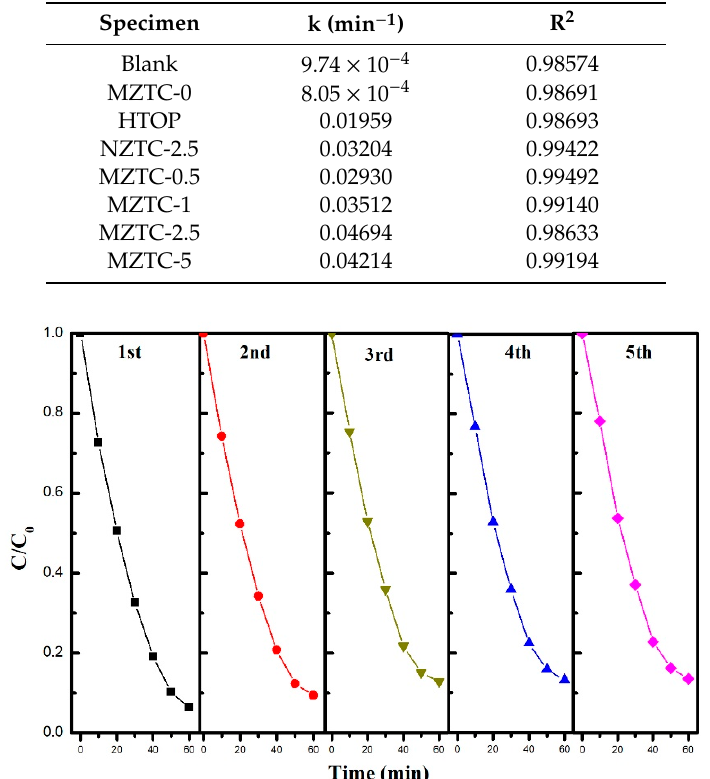
Table 2. The parameters of the photocatalytic degradation reactions. (k = reaction rate constant;